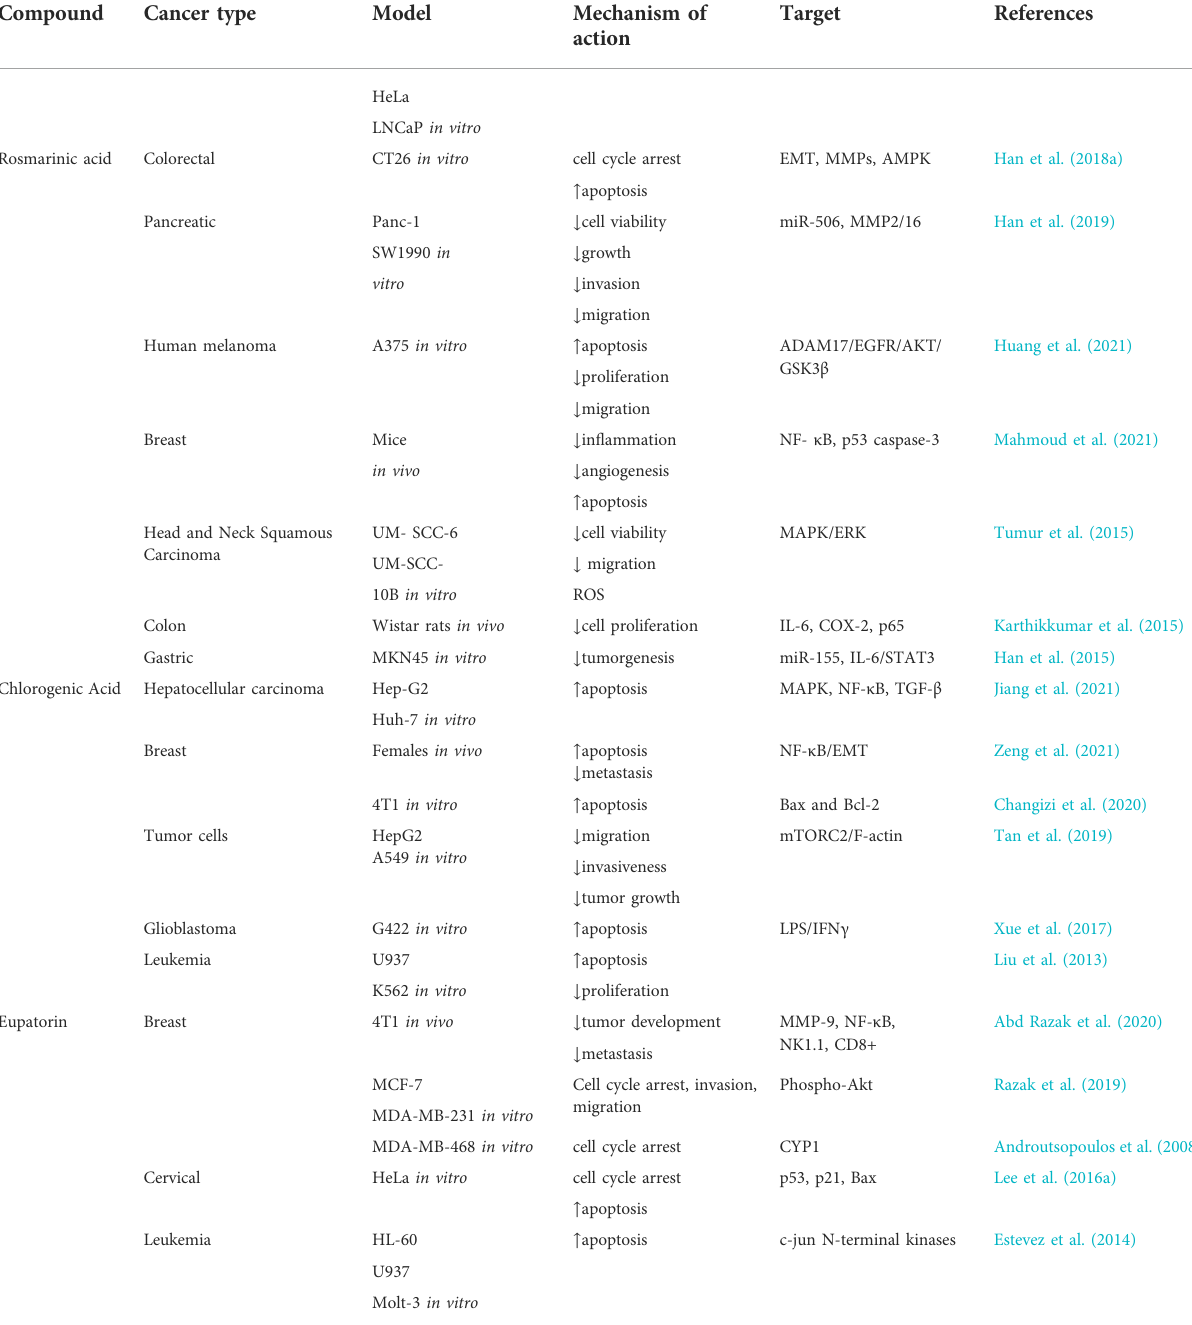
TABLE 1 ( Continued ) Anticancer perspectives of polyphenols along with their mechanism of action and signaling